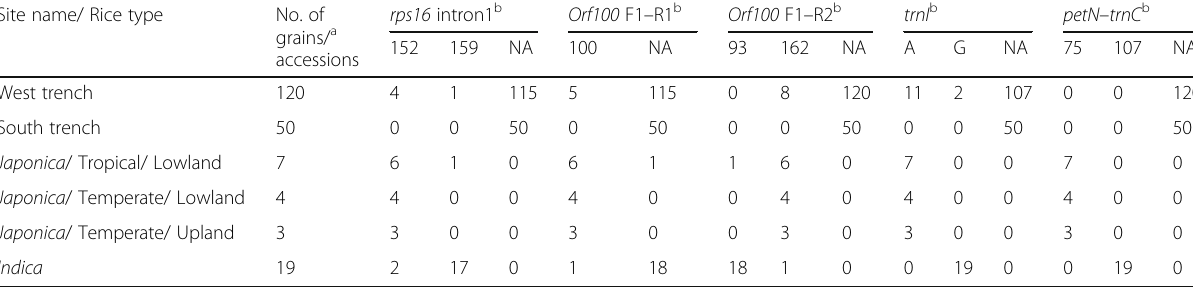
Table 3 DNA genotype of archaic grains and modern rice accessions by specific primer set in the chloroplast genome Site name/ Rice type